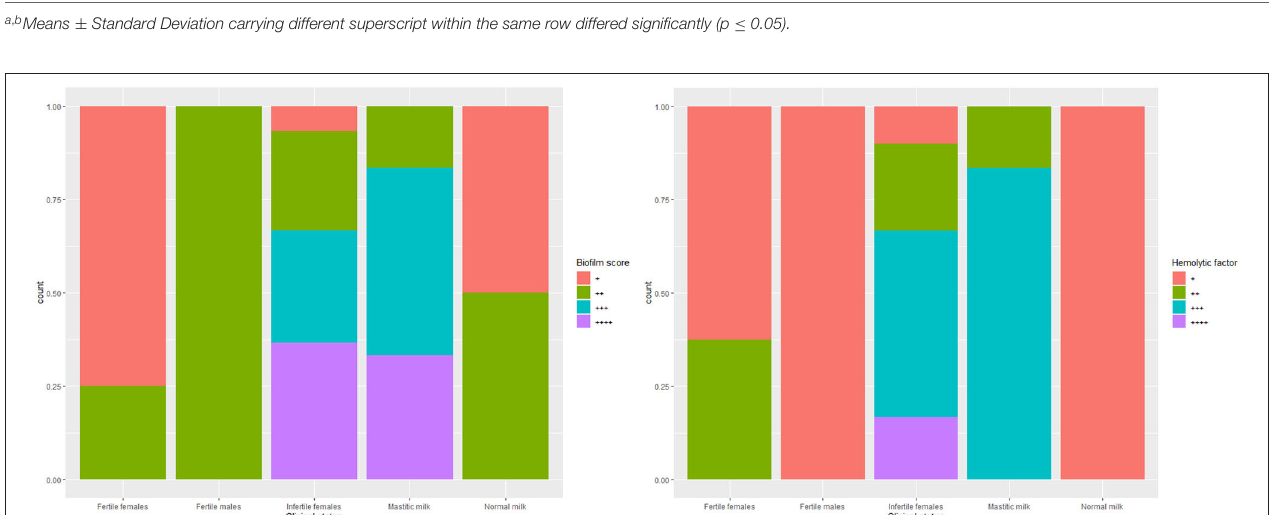
The results of antifungal susceptibility testing revealed that 2 (4.17%) and 3 (8.33%) of isolates were resistant to fluconazole and flucytosine, respectively. Fluconazole is fungistatic rather